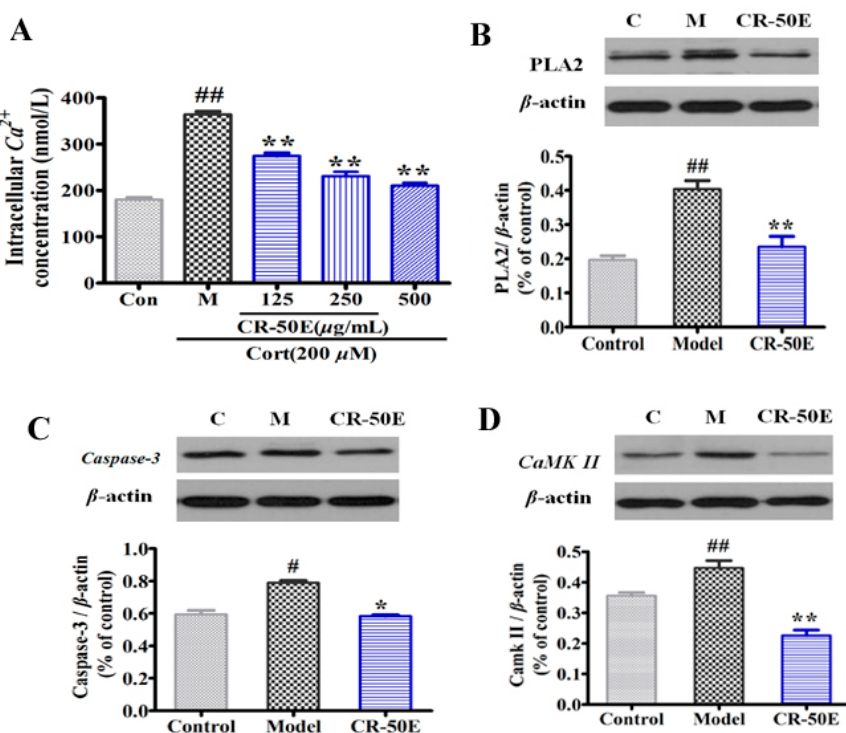
Figure 4. ( A ): Intracellular Ca 2+ concentration in corticosterone-induced PC12 cells; ( B ): the protein expression level of PLA2, CaMK II, and caspase-3 in different group. Cells were exposed to 200 μ M of corticosterone in the absence or presence of CR-50E for 24 h. Results are presented as means ± SD ( n = 6). ** p < 0.01, compared with corticosterone-treated group (Cort), # p < 0.05 or ## p < 0.01, compared with control group.